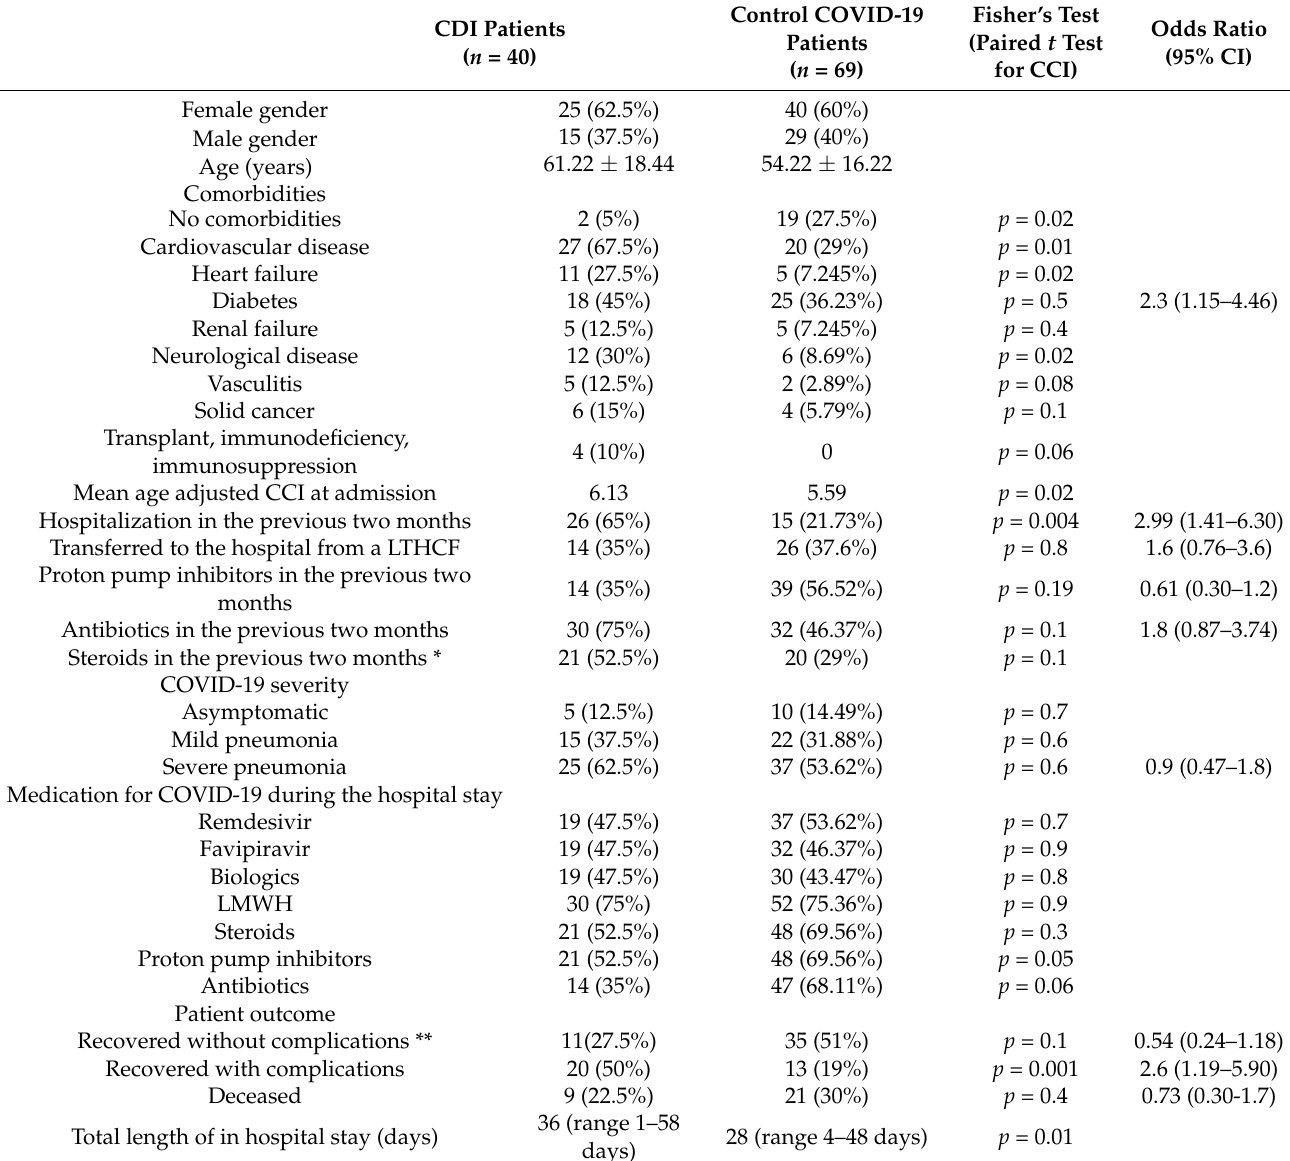
Table 1. Demographic data, clinical features, comorbidities, and outcome of the 40 patients with COVID-19 and C. difficile infection (CDI) and 69 COVID-19 controls included in the